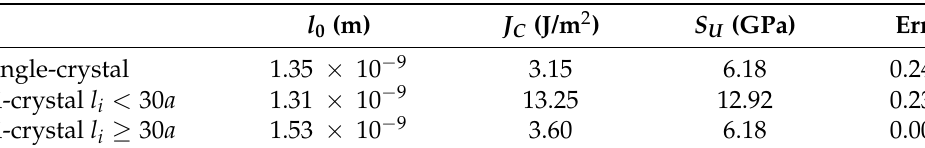
Table 3. Fracture toughness estimation based on CTOD .